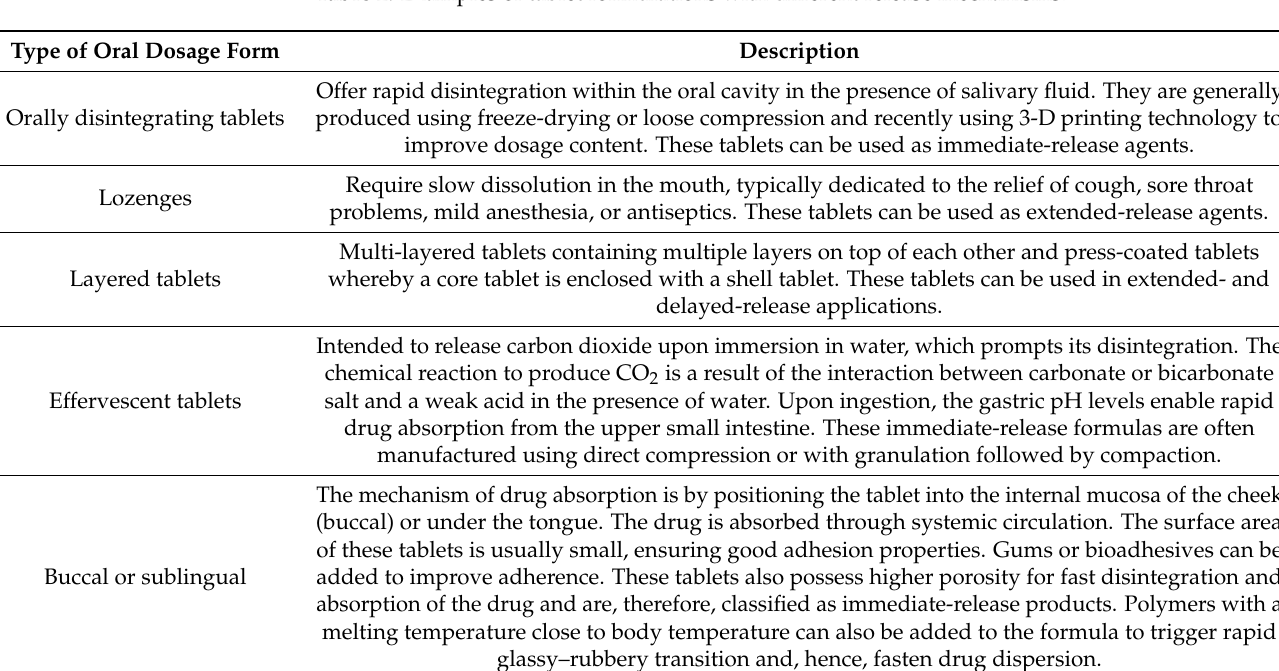
Table 2. Examples of tablet formulations with different release